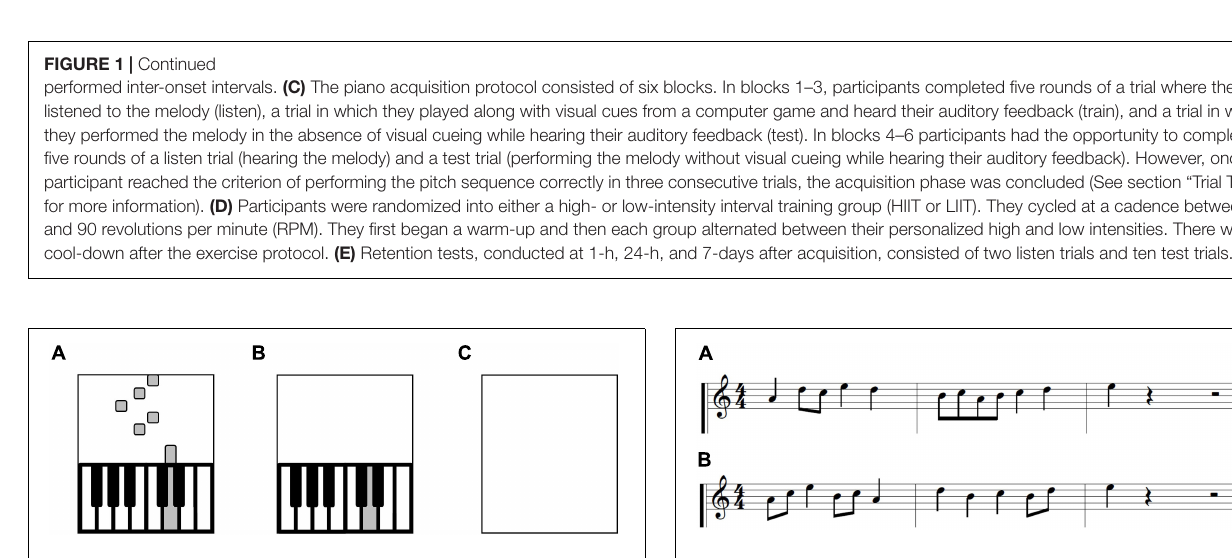
FIGURE 2 | Trial Types. (A) Training trial with visual cues. (B) Test trial in blocks 1–3 without visual cueing. (C) Test trial in blocks 4–6 without on-screen keyboard.